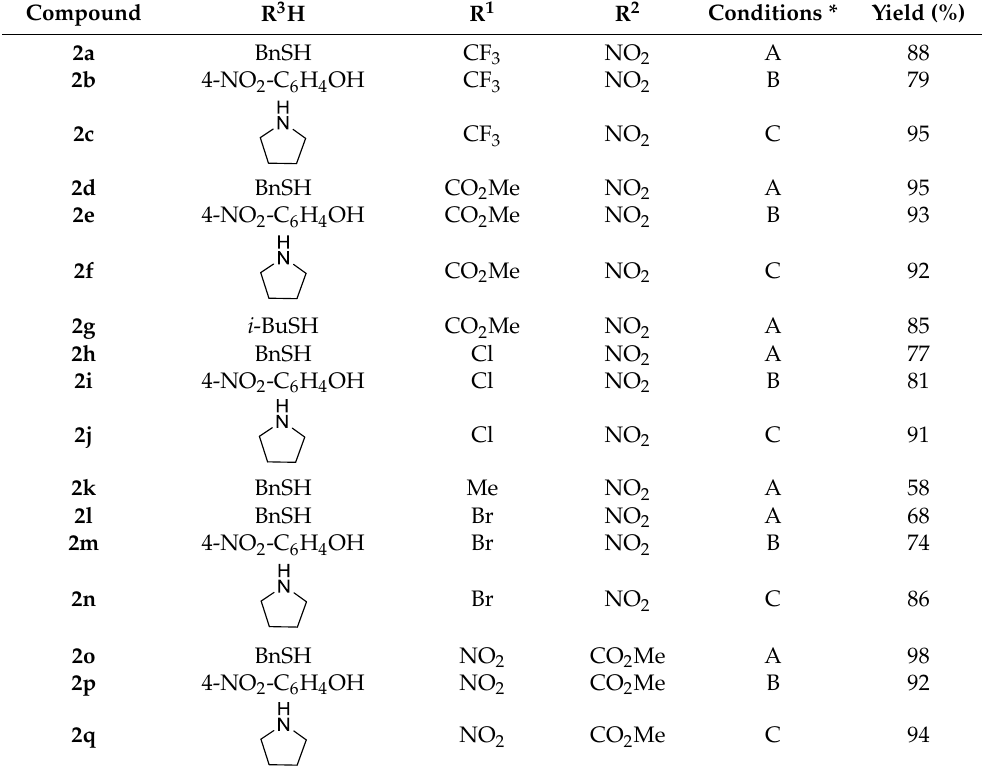
Table 1. Reaction conditions and isolated yields of compounds 2a – q.